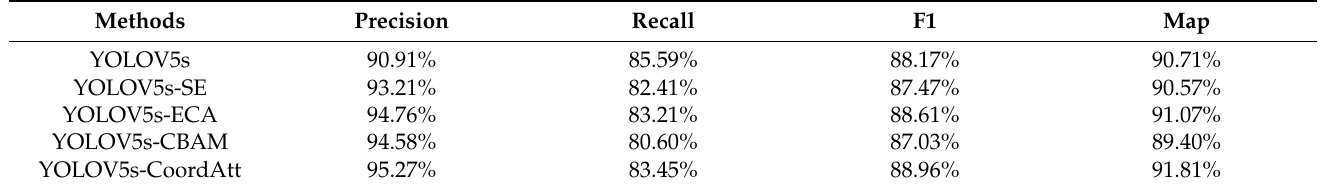
Table 5. The evaluation results of various pavement crack detection methods (self-building datasets).